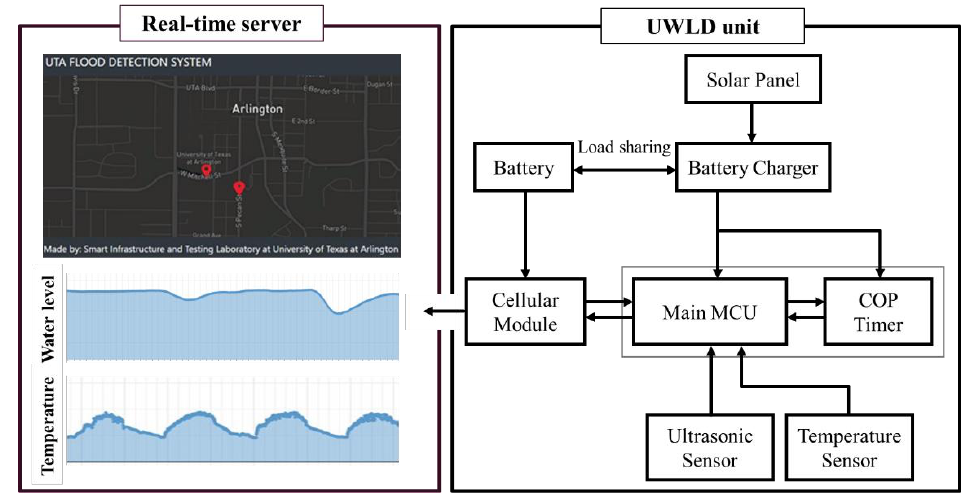
Figure 1. System representation of the basic UWLD system: real-time user interface platform plotting real-time temperature and water level ( left ) and UWLD-1 unit representation ( right ). It implies the data from the remote UWLD unit can be monitored in real-time on the website.